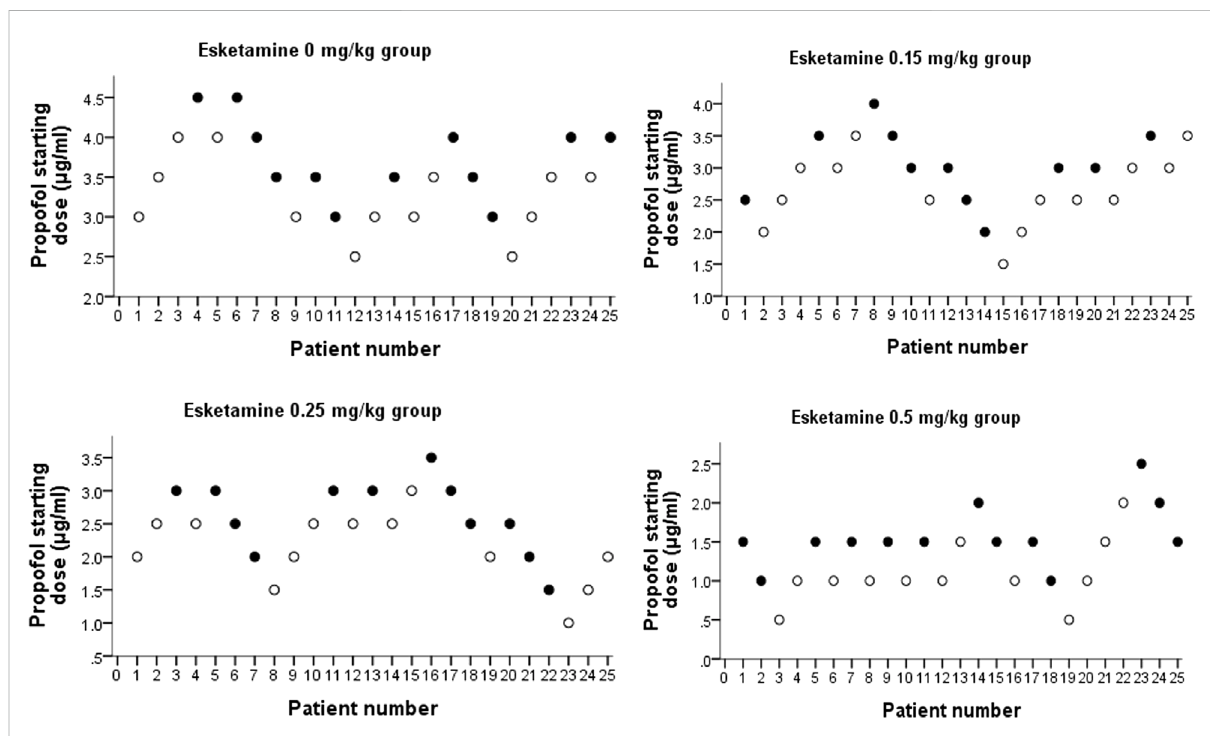
FIGURE 2 Dixon up-and-down plots for four groups. “ C ” represents failure, and “ ○ ” represents success.